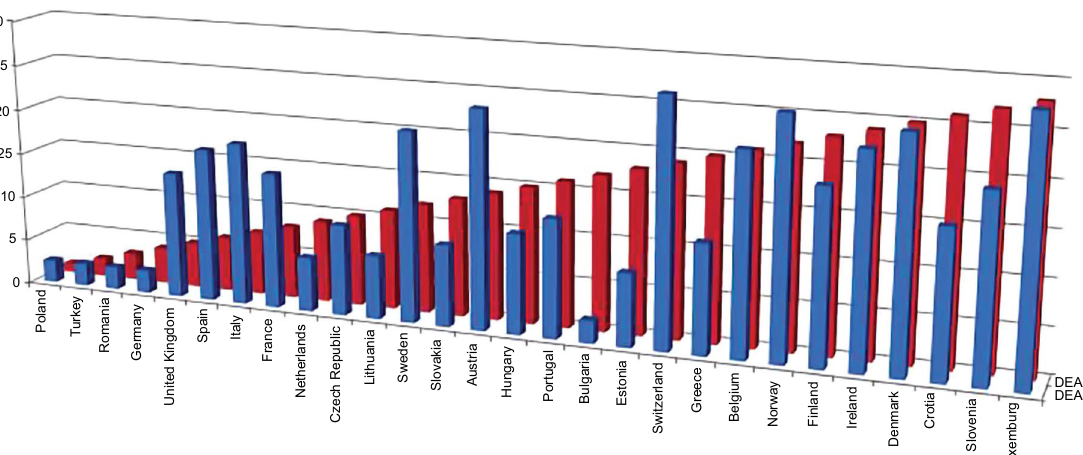
Fig. 3. Ranking orders with DEA-PC and DEA CCR method without the outlier ( source : own